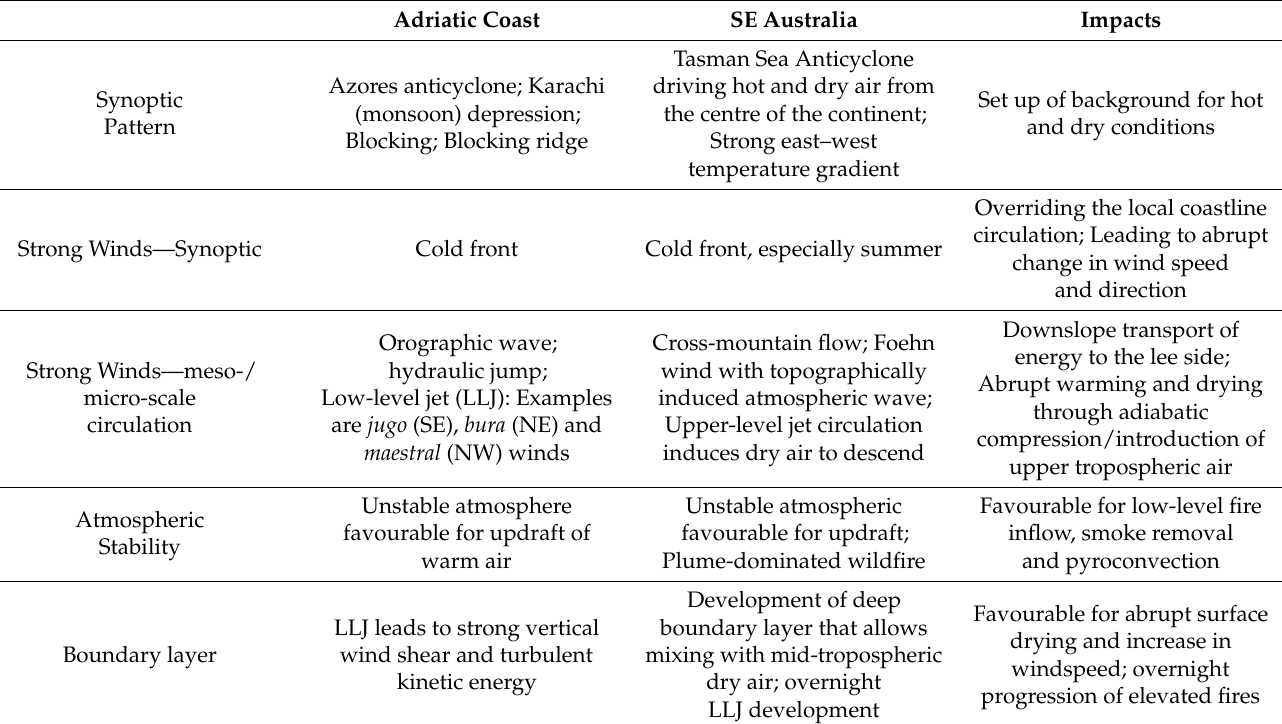
Table 1. Summary and comparison of the multiscale drivers of wildfire over the Adriatic Coast and Southeast Australia. The last column describes their